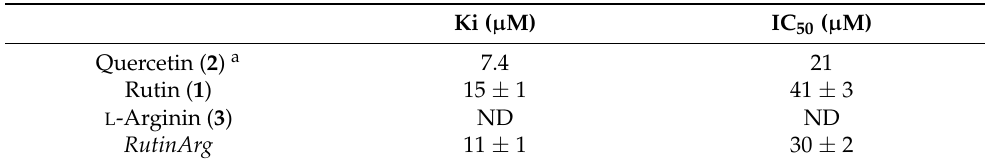
Table 2. Inhibition constant (K i ) and effective inhibition concentration 50% (IC 50 ) for the compounds tested.